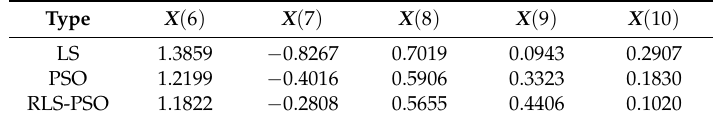
Table 4. The identified values of X ( 6 : 10 ) .